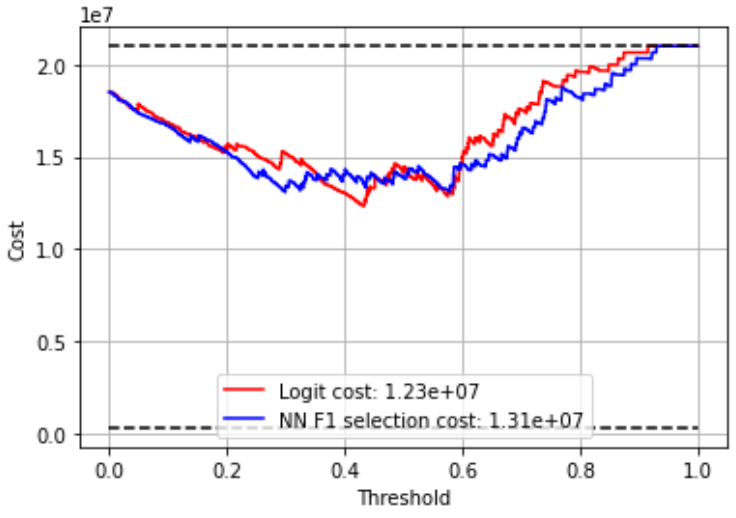
Figure 12. Insurance provider-related